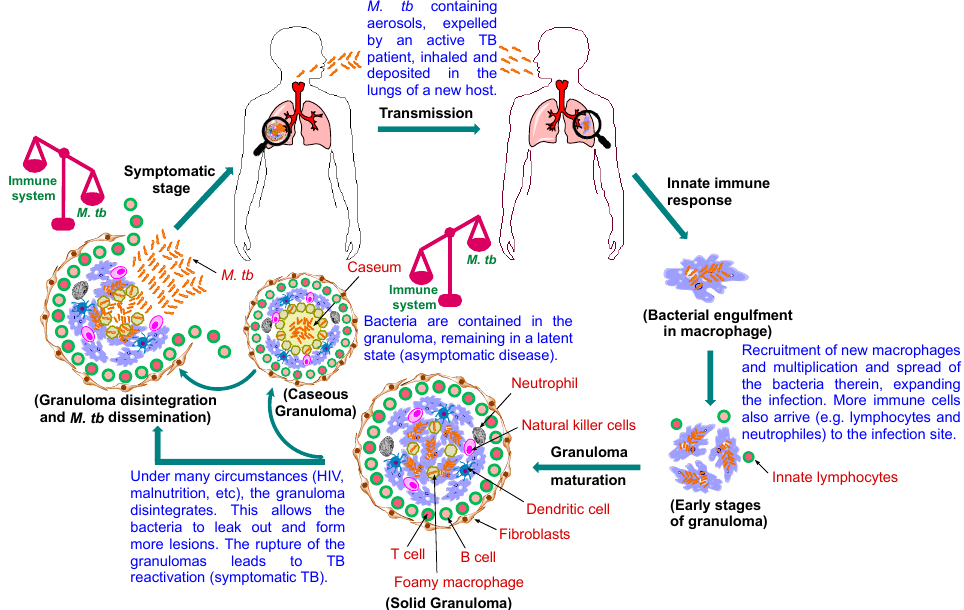
Figure 2. Pathophysiology of pulmonary TB. Following the M. tb transmission to the new host, the bacilli enter the lung and get ingested by macrophages. Further immune cells are recruited to wall off the infected macrophages, leading to the formation of the granuloma, the hallmark of TB. Healthy individuals remain latently infected, and the infection is kept at bay at this stage, but it is prone to the risk of reactivation. Foamy macrophages release their lipid content when they necrotise, leading to caseation (cheese-like structure). Caseum is a decay manifested at the core of the granuloma that compromise its rigid integrity. As the granuloma develops, the bacilli commence to seep out of the macrophages into the caseum layer. When the reactivation occurs, M. tb proliferates and the bacterial load becomes overwhelmingly high, whereupon the granuloma rupture, disseminating the bacteria to the airways. The bacilli are then expectorated as contagious aerosol droplets, restarting the cycle, infecting other individuals.